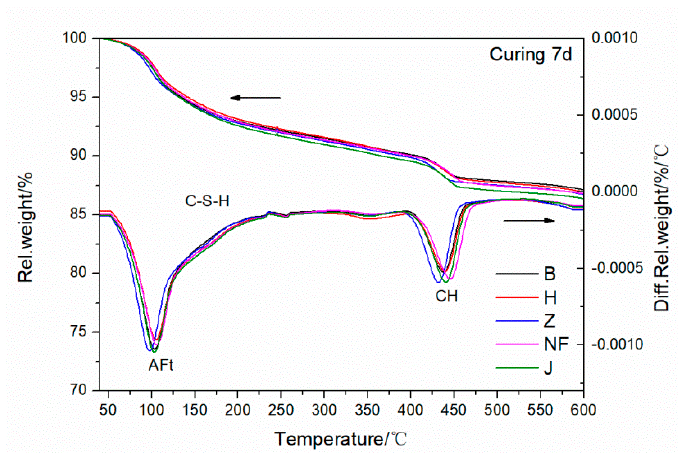
Figure 6. Effects of different superplasticizers on cement hydration after 7 days.